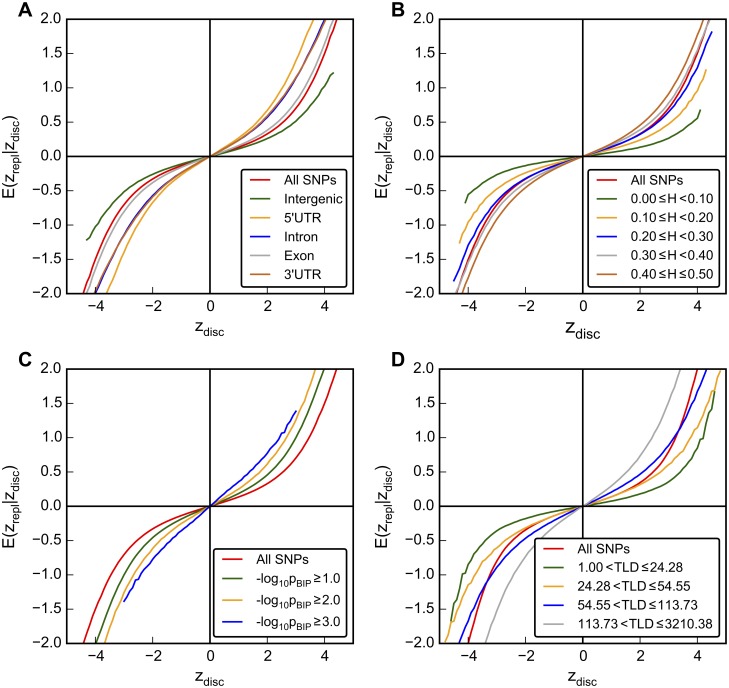
Mean replication z-scores stratified by genomic annotation, pleiotropy and heterozygosity.The conditional mean z-scores in replication sample (y axis) were plotted against the z-scores in the discovery sample (x axis). The shrinkage of replication z-score is differentiated by A.) genomic annotation categories (All SNPs; Intergenic; 5’ untranslated region,5’ UTR; Intron; Exon; and 3’ untranslated region, 3’ UTR), B.) by heterozygosity (H) intervals, C.) by associations with bipolar disorder (BIP; All SNPs; -log10 p ≥ 1.0; -log10 p ≥ 2.0; and log10 p ≥ 3.0) and D.) by total LD (TLD) intervals. All plots were generated by randomly assigning 26 of the PGC Schizophrenia sub-studies as discovery sample and 26 as replication sample (split half). The average value over 500 iterations is shown.